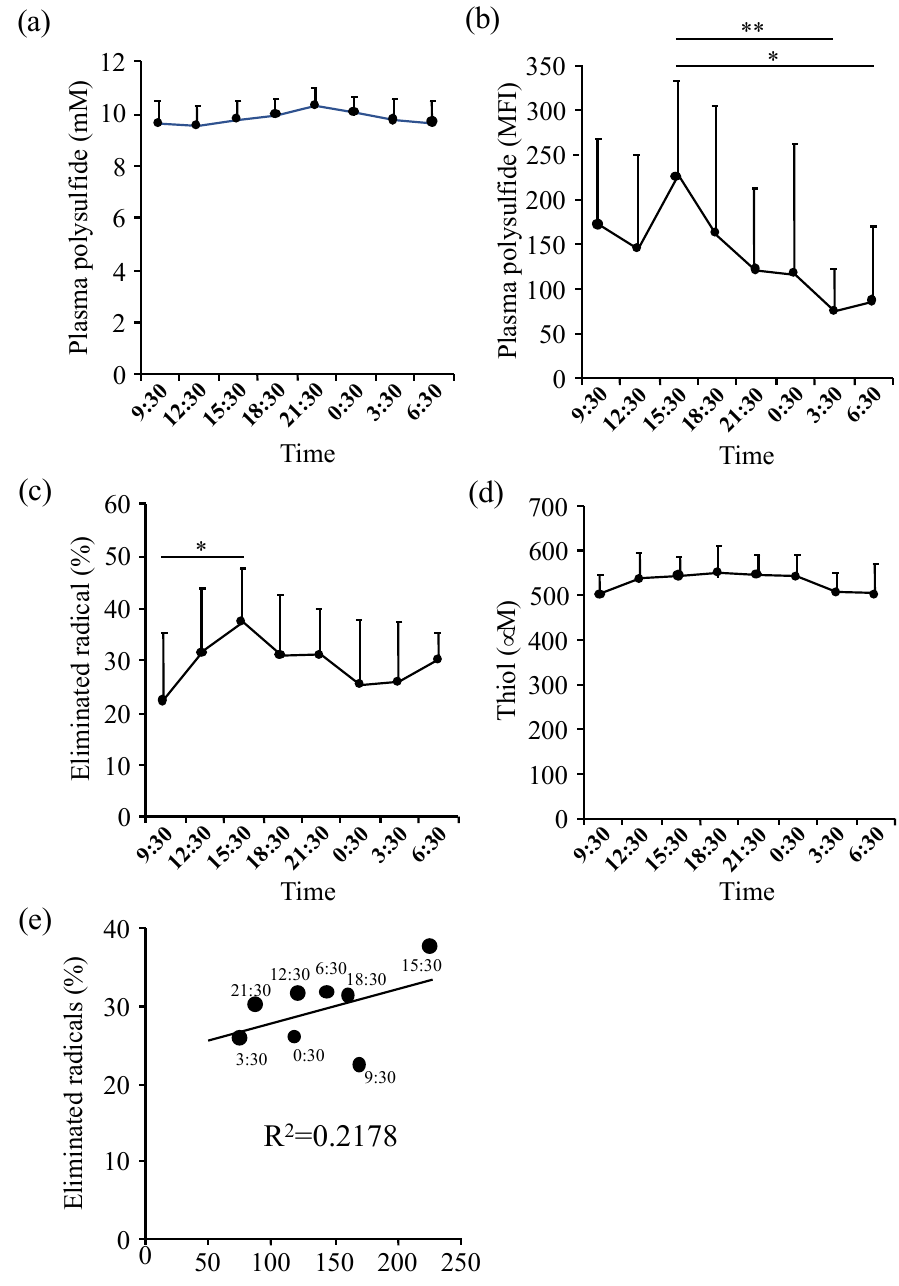
Figure 4. Circadian rhythms of plasma redox parameters. Diurnal variation of ( a ) plasma polysulfide measured by EMSP, ( b ) sulfane sulfur detected by SSP4, ( c ) AAPH radical elimination activity, and ( d ) thiol performed DTNB analysis was assessed. ( e ) Association between SSP4 and AAPH radical elimination activity by different time. Longitudinal axis shows the ratio of eliminated AAPH radical by plasma. Horizontal axis is the mean fluorescence intensity (MFI) of SSP4. Each point is the average score of the plasma samples collected from healthy subjects at the same time. * p < 0.05, ** p < 0.01 between